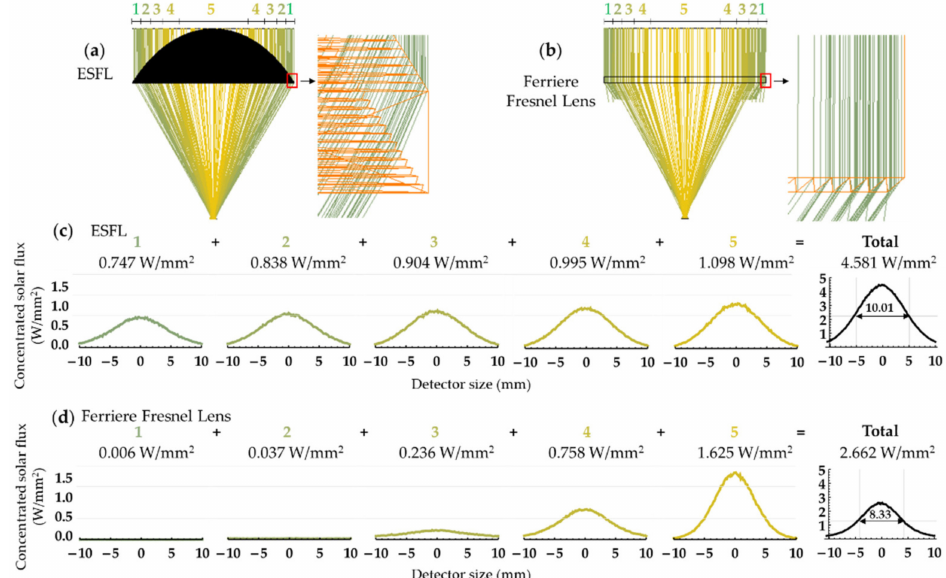
Figure 11. ( a ) The ESFL and ( b ) the Ferriere Fresnel lens irradiated by five concentric solar sources with identical area and power. ( c , d ) Respective concentrated solar fluxes for the ESFL and the Ferriere lens, respectively; the combined solar fluxes are also